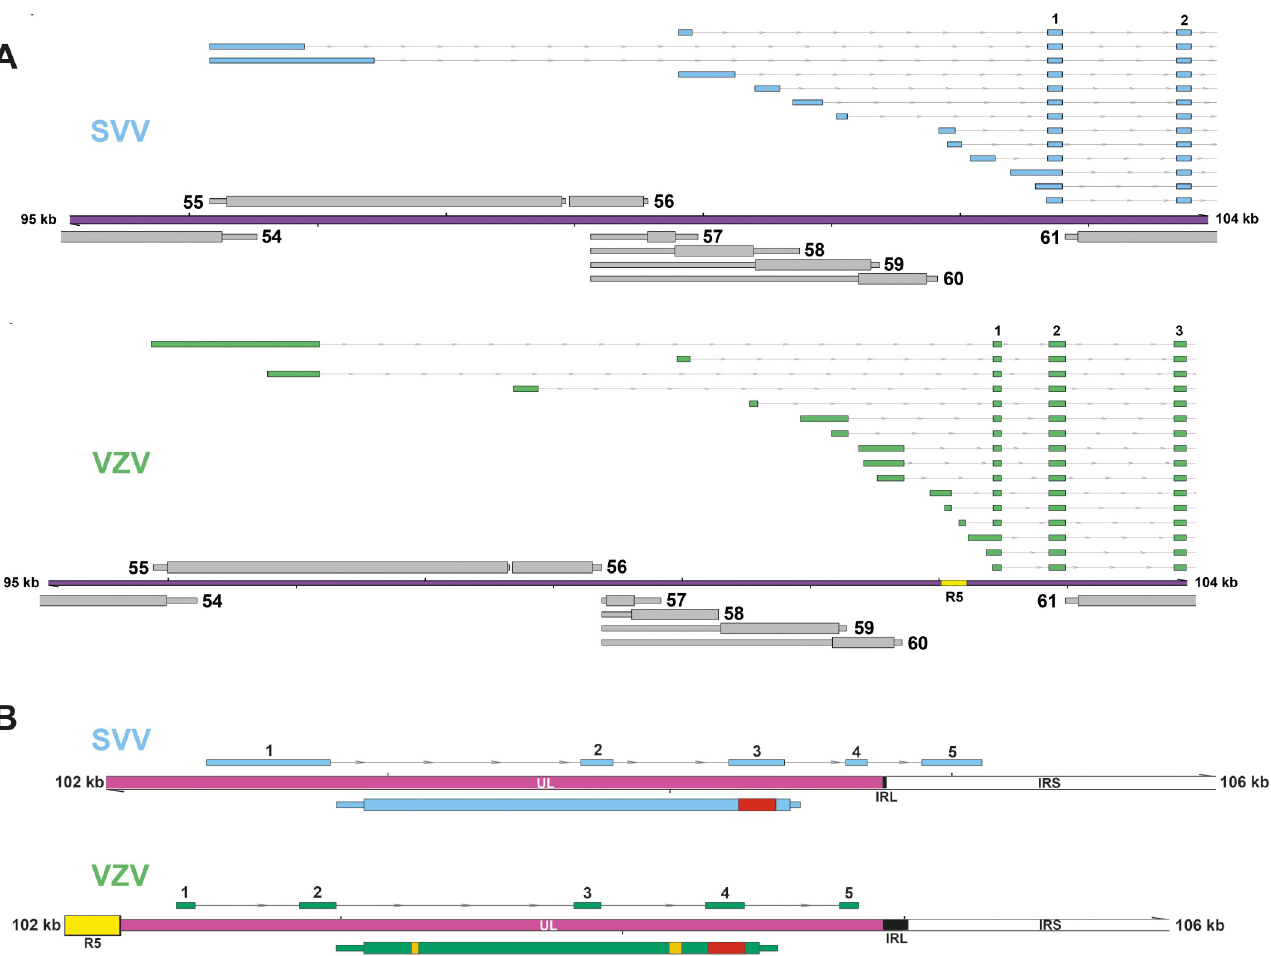
Fig 10. VLT is highly conserved between SVV and VZV. (A) Comparison of the genomic location of SVV (blue) and VZV (green) most abundantly used upstream VLT exons. (B) Comparison of SVV (blue) and VZV (green) core VLT location and structure with respect to other genomic features, such as the IRL/ IRS, and ORF61 on the opposite strand. Red box and yellow boxes indicate sequences encoding the RING and SIM domains of VZV